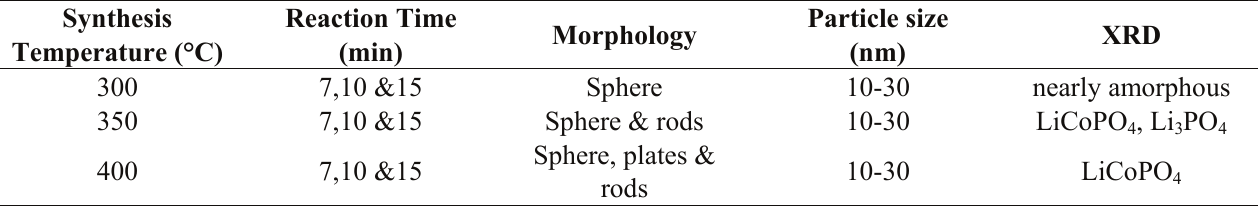
Table 2. Synthesis conditions for LiCoPO as starting materials.